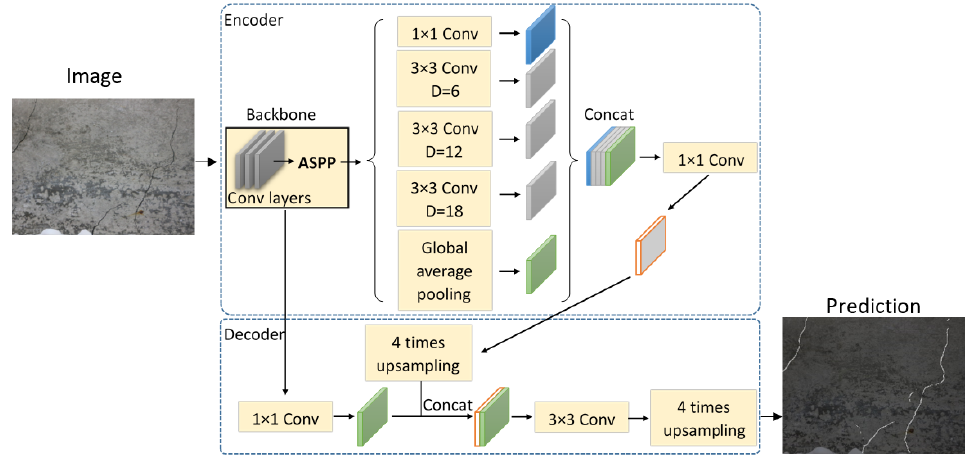
Figure 1. The structure of Deeplabv3+.